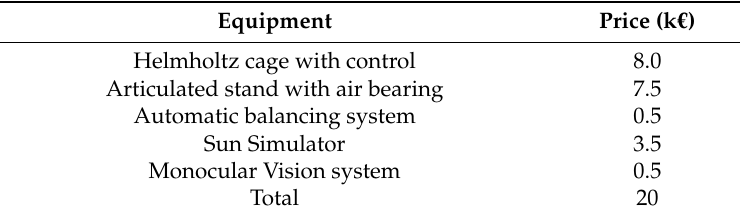
Table 6. Cost breakdown of the